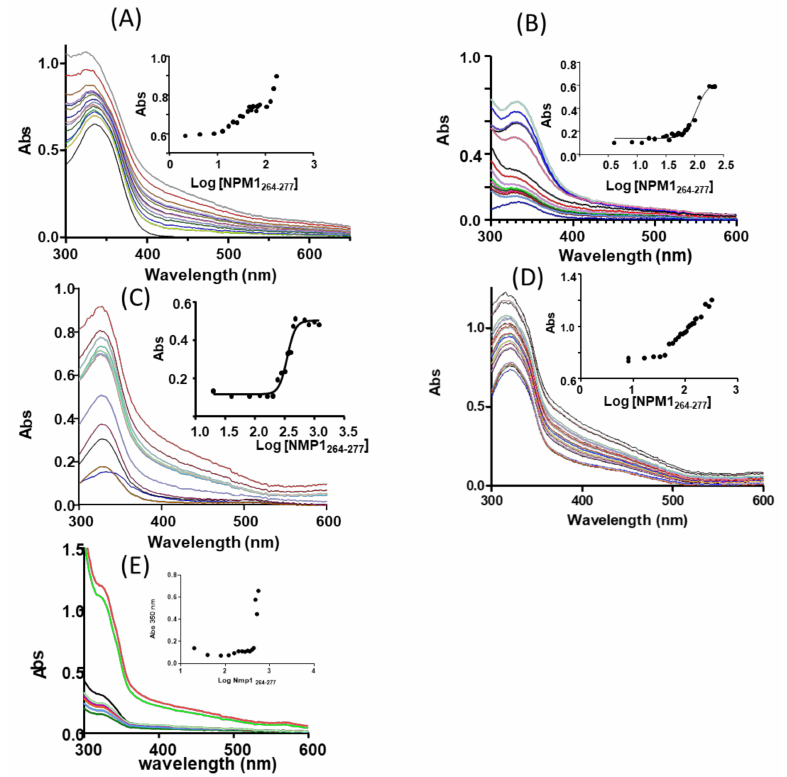
Figure 4. Absorption spectra of ( A , B ) compound 2 , ( C , D ) compound 3 and ( E ) compound 1 in UV irradiated ( B , D ) and not irradiated ( A , C , E ) preparation, upon the addition of increasing amount of NPM1 264–277 . As insets UV intensities at ~330 nm versus Log concentration of NPM1 264–277 have been reported.